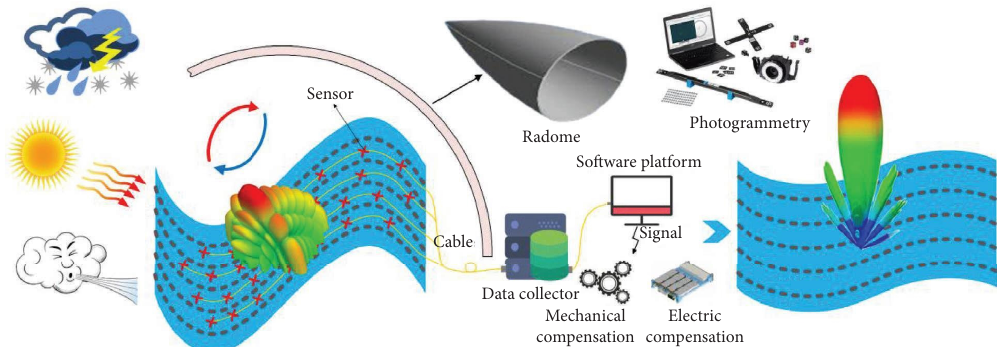
Figure 14: Schematic diagram of APAA array monitoring and performance regulation in service